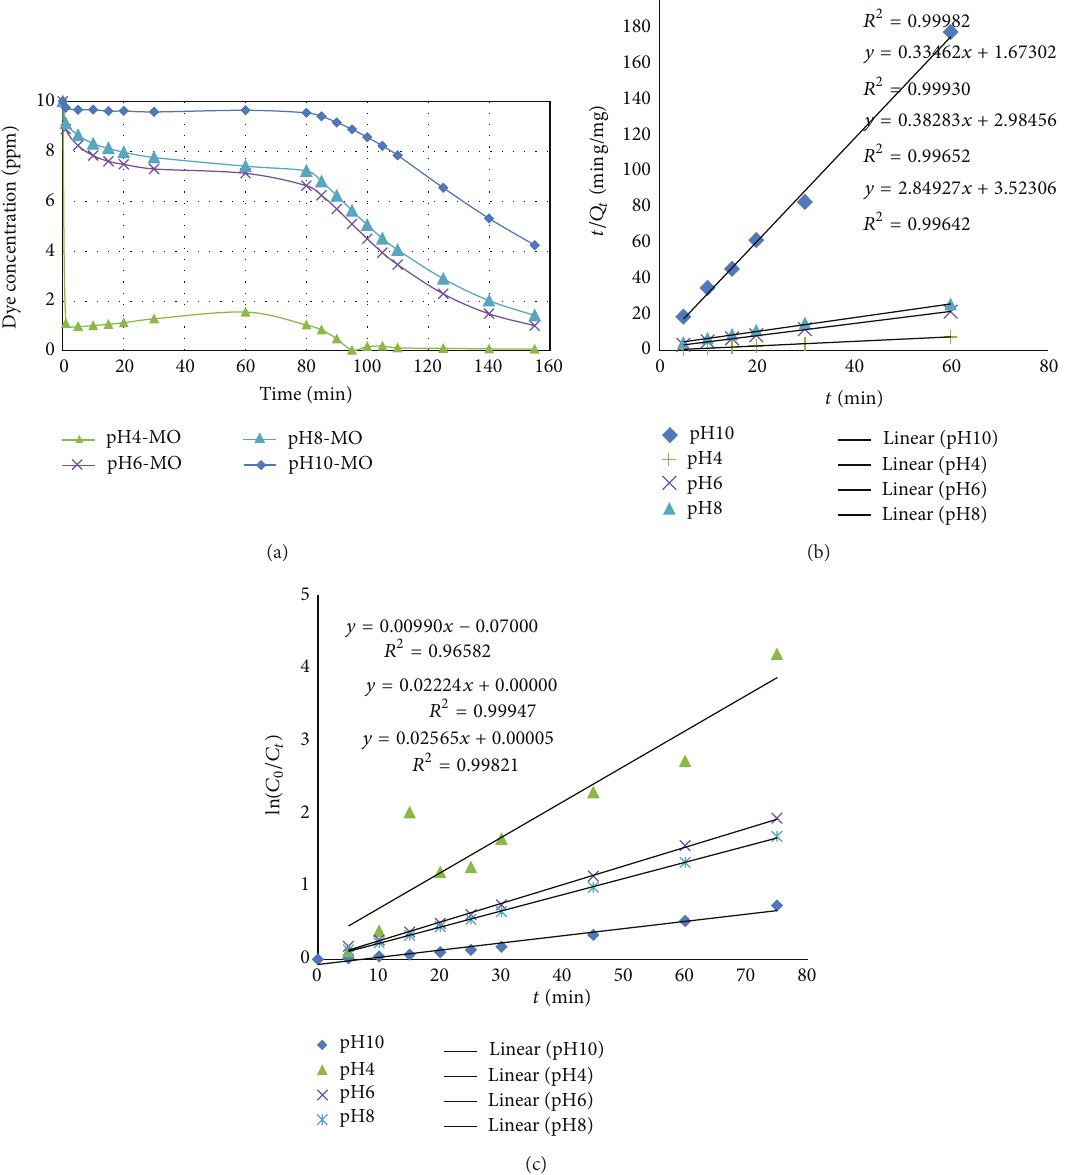
Figure 10: (a) Methyl orange adsorption-photodegradation by epichlorohydrin cross-linked catalyst composite at different initial solution pH; (b) the corresponding linearized plots of pseudo-second order adsorption kinetics; and (c) the corresponding linearized plots of pseudo- first order photodegradation